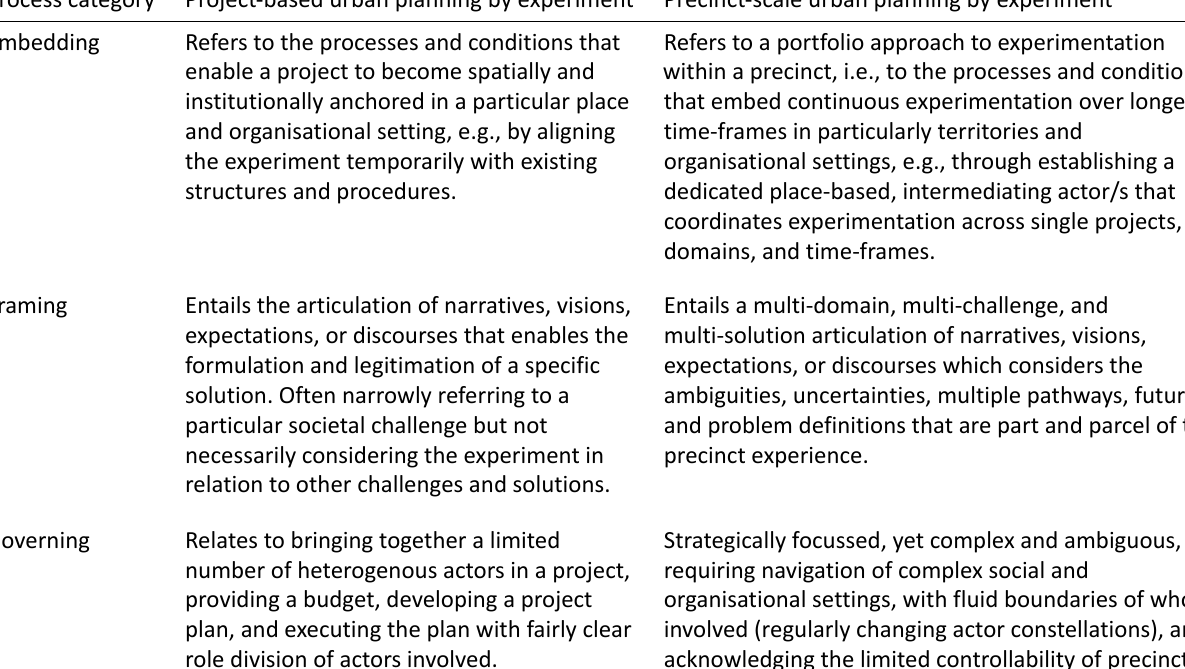
Table 1. Processes of ‘project-based’ vs ‘precinct-scale’ urban planning by experiment. Process